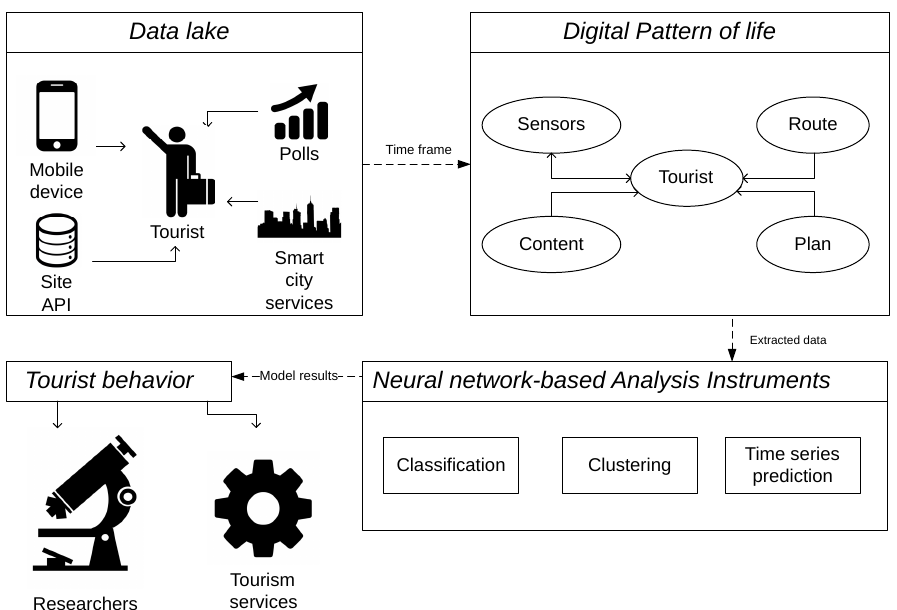
Figure 1. Tourist behaviour analysis reference